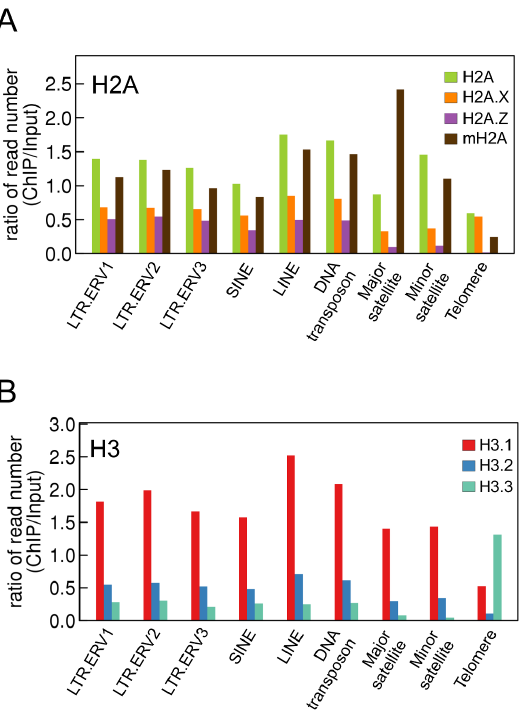
Figure 6. Enrichment of histone variants in repeat elements. Bars represent the ratios of the number of ChIP reads to that of input reads in repeat elements.